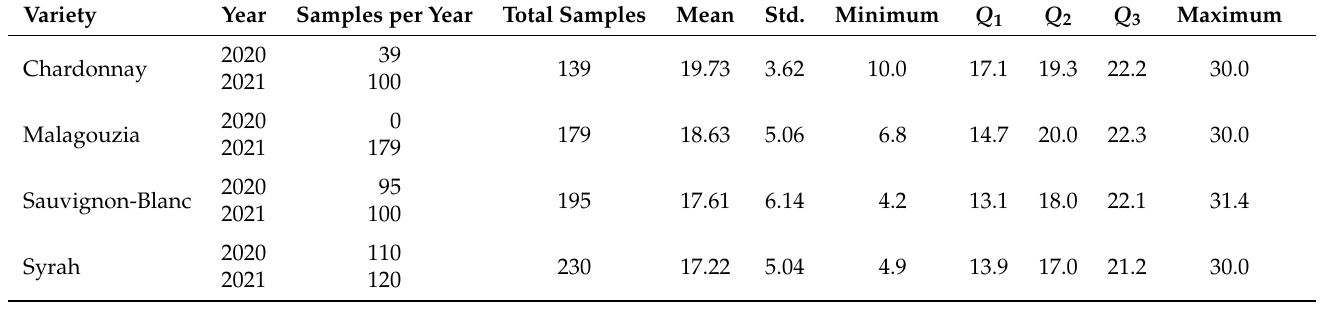
Table 2. Major statistical moments of the °Brix content across the four different grape varieties that were collected, where Std is the standard deviation, Min and Max are the minimum and maximum values, and Q 1 , Q 2 and Q 3 are the 1st, 2nd, and 3rd Quartile or 25th, 50th, and 75th percentiles, respectively.